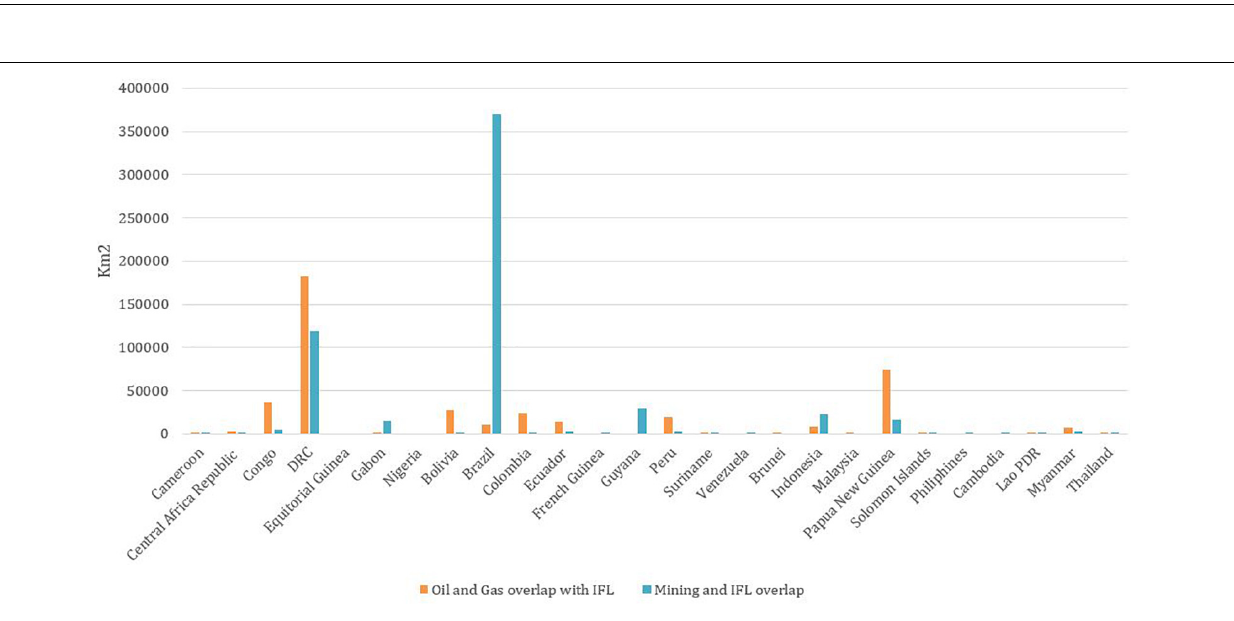
Frontiers in Forests and Global Change |